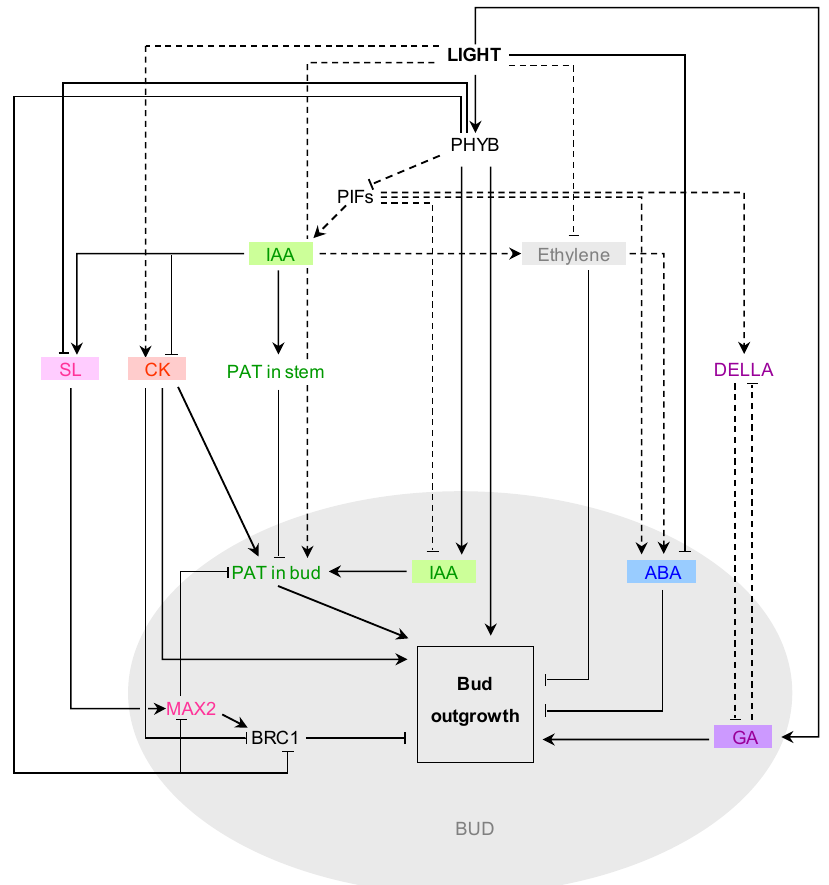
Figure 1. Interactions between light and hormone signaling. Full connectors represent interactions in the context of bud outgrowth, while dotted connectors represent interactions during other